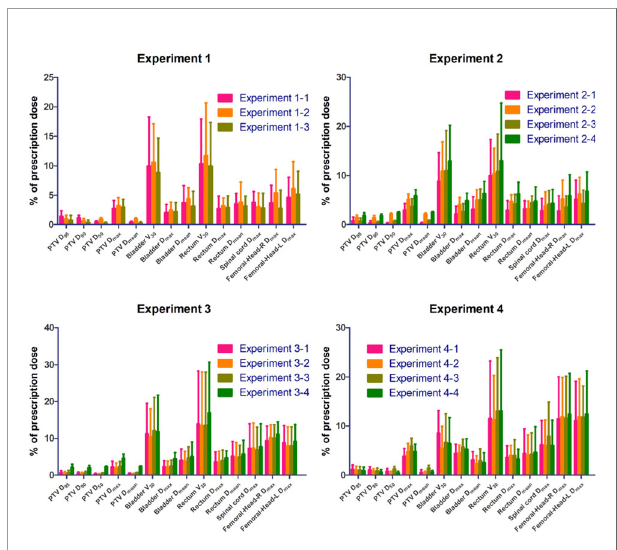
FIGURE 4 | The absolute percentage errors for